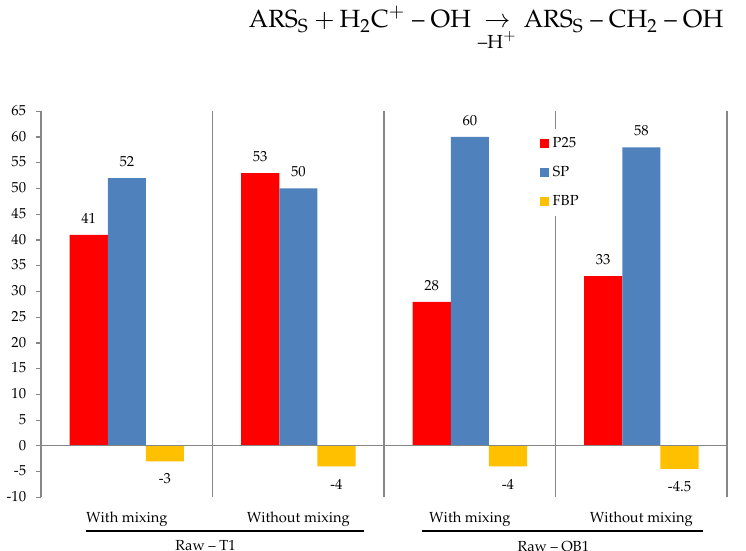
Figure 4. The effect of mixing on the modification process: toluene amount was 40.0 kg/100 kg raw; formalin amount (including formaldehyde) 10.0 (3.7) kg/100 kg raw; catalyst amount (НСl) 2.5 kg/100 kg raw; temperature 120 °C; duration 3 h.